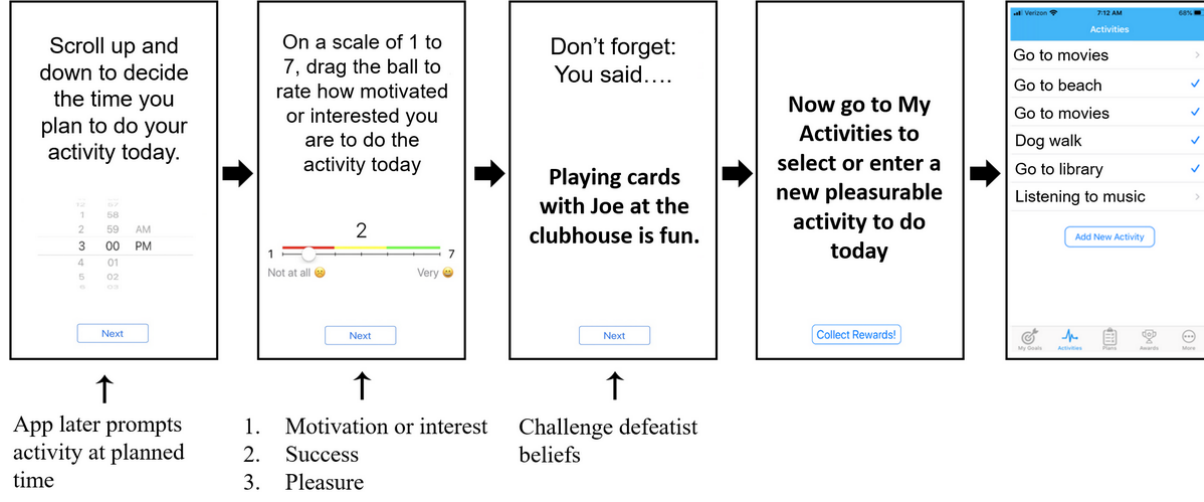
Figure 1. Screenshots of the CBT2go app for planning pleasurable or social activity. Low motivation, high defeatist attitudes (ie, anticipated success), or low anticipatory pleasure ratings triggered personalized reappraisal evidence. A separate My Activities tool was used to plan and savor